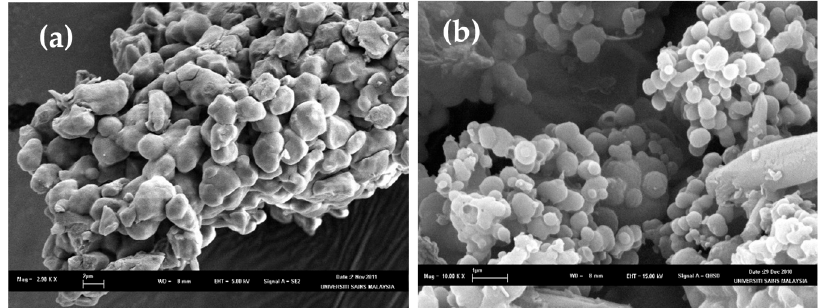
Figure 2. Scanning electron microscopes (SEMs) for ( a ) non-cross-linked CPM (scale: 2.98 K) and ( b ) cross-linked CPM (scale: 10 K).